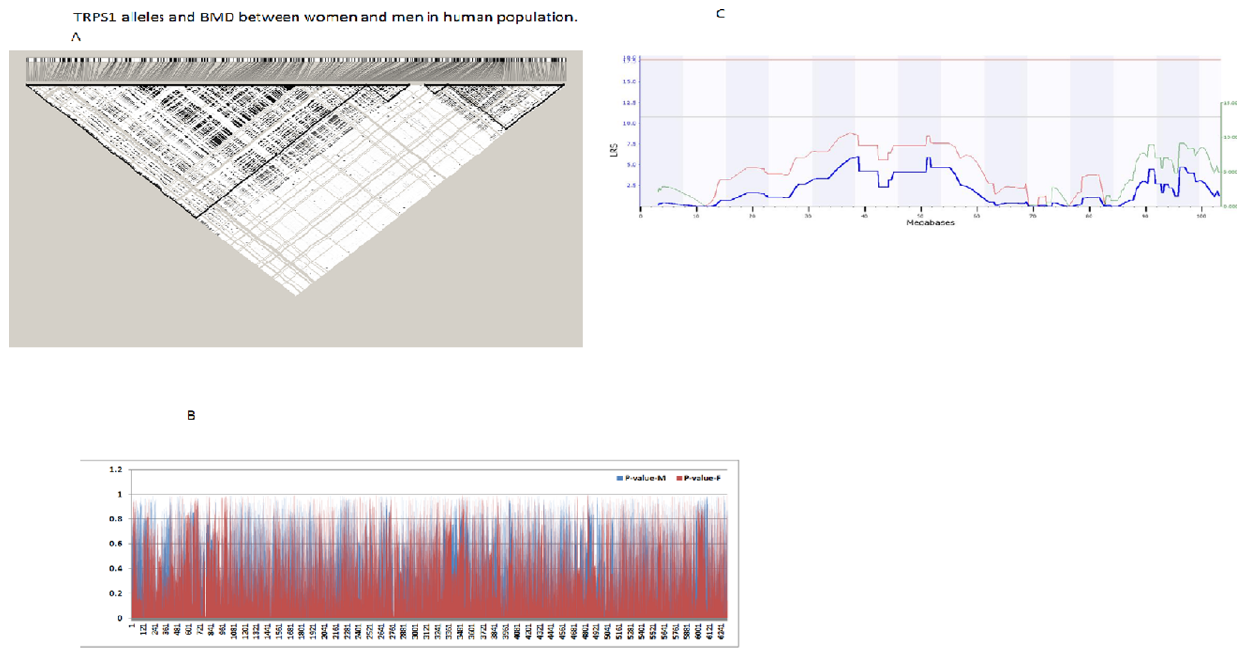
Figure 4. TRPS1 alleles and BMD between women and men in human population. Figure 4A. The linkage disequilibrium (LD) plot of the SNPs within the TRPS1 gene. It was plotted by the software Haploview. Figure 4B. P values of 6310 among women and men. The lower the P value is, the stronger association between SNP allele and BMD is. Y-bar indicates the P values of each SNP in women and in men with different colors. X-bar indicates the number of SNP. Different color in many individual bars can be seen because the different P values between women and men in those SNP alleles. Figure 4C. Potential detection of QTL using data of BMD of the femur in female mice.